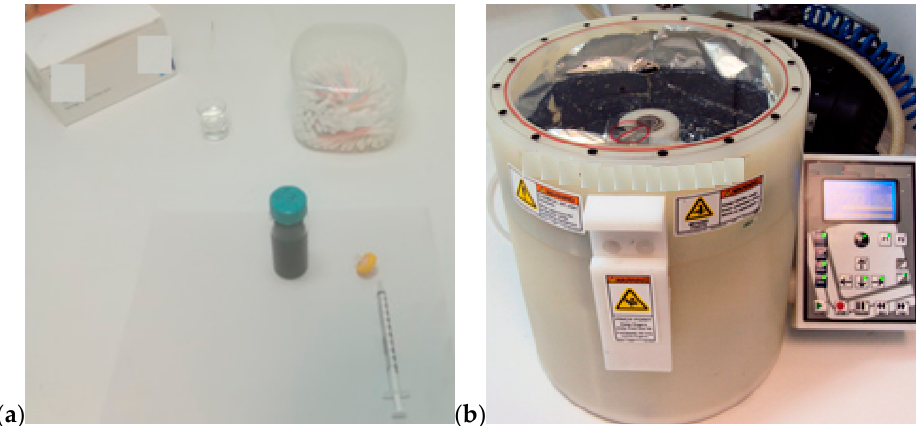
Figure 6. ( a ) Materials and equipment for deposition of PEDOT:PSS; the hole transport layer (HTL), ( b ) spin coater used for the static spin coating of PEDOT:PSS.